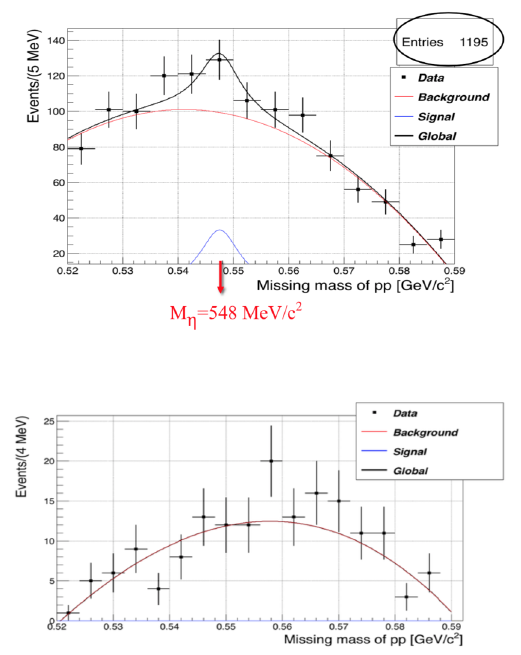
Figure 8. Illustration of the fitting procedure for the final selection of η → e + e − candidates. We observe no statistically significant